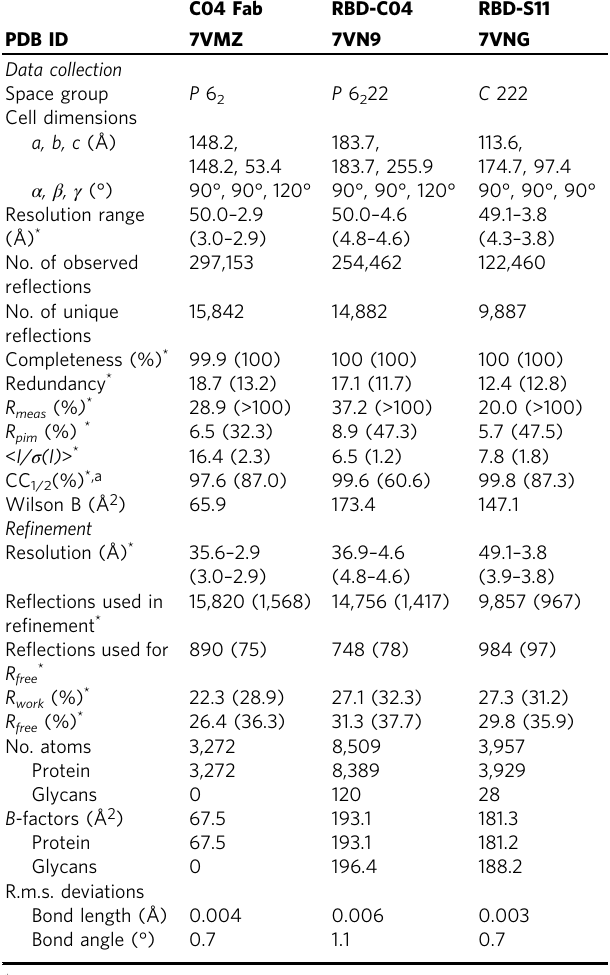
Table 1 X-ray data collection and re fi nement